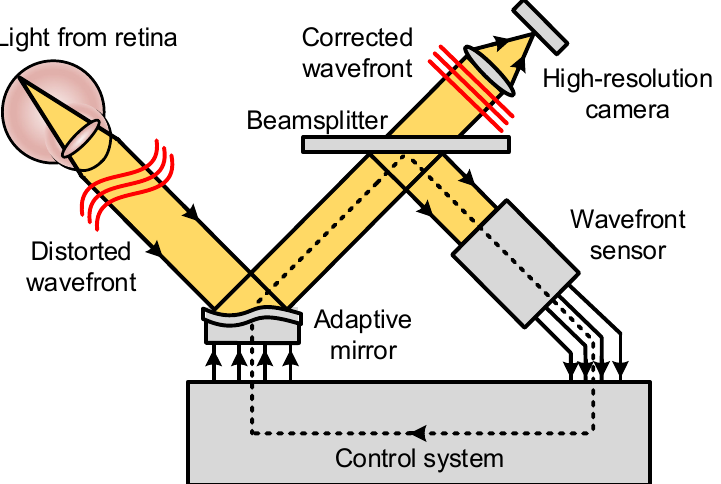
Figure 2. Schematic diagram of a sensor-based AO system for retinal imaging (Adapted with permission from Ref. [16]. Copyright 2011, Association for Research in Vision and Ophthalmology).